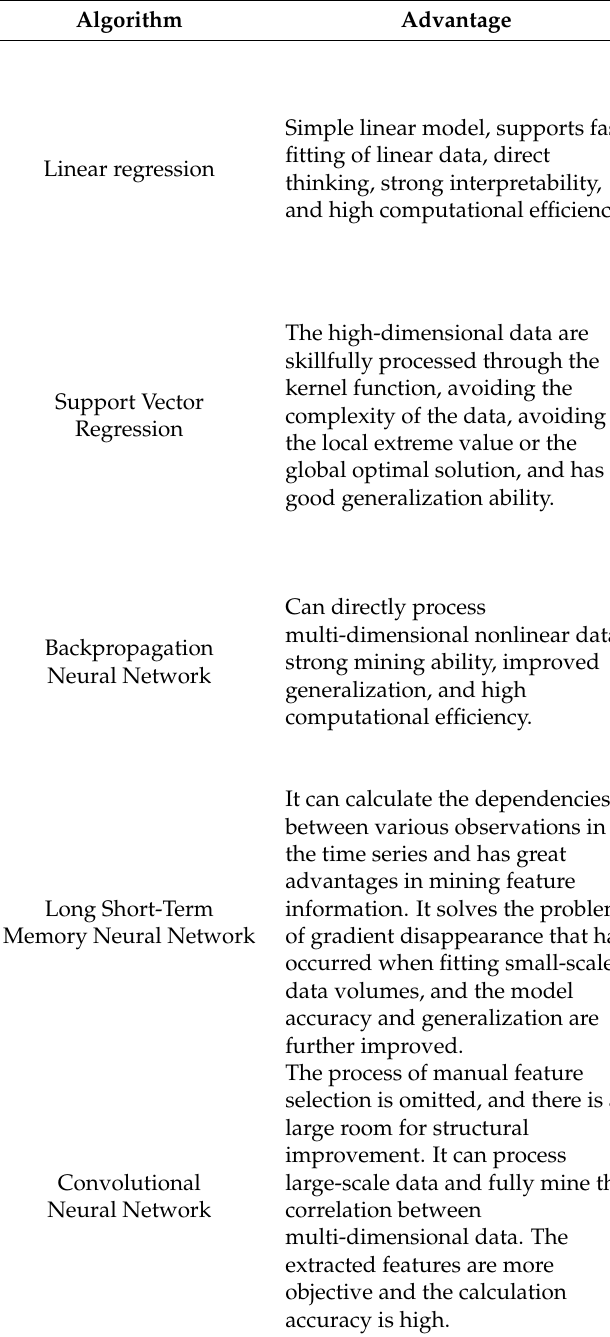
Table 8. Comparison of commonly used data-driven